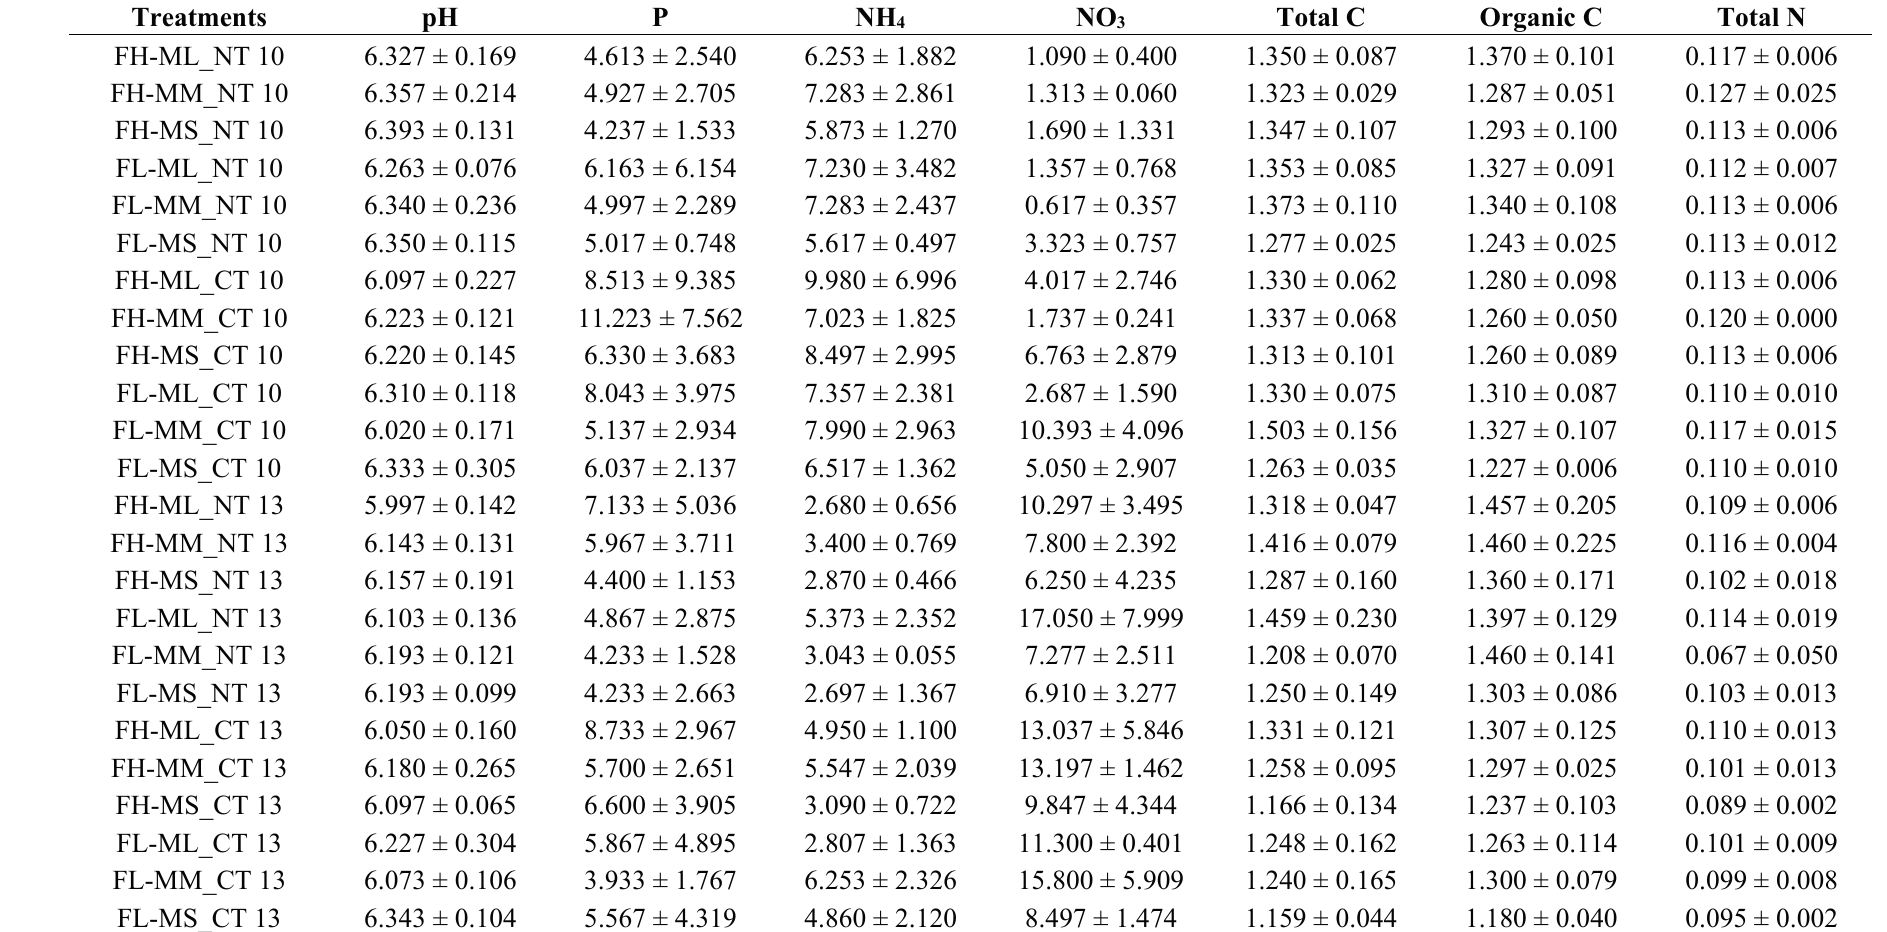
Table A1. Selected soil chemical analysis measured at 0–100 mm depth in the various treatments during the initial (2009/2010) and final (2012/13) seasons of the Zeekoegat